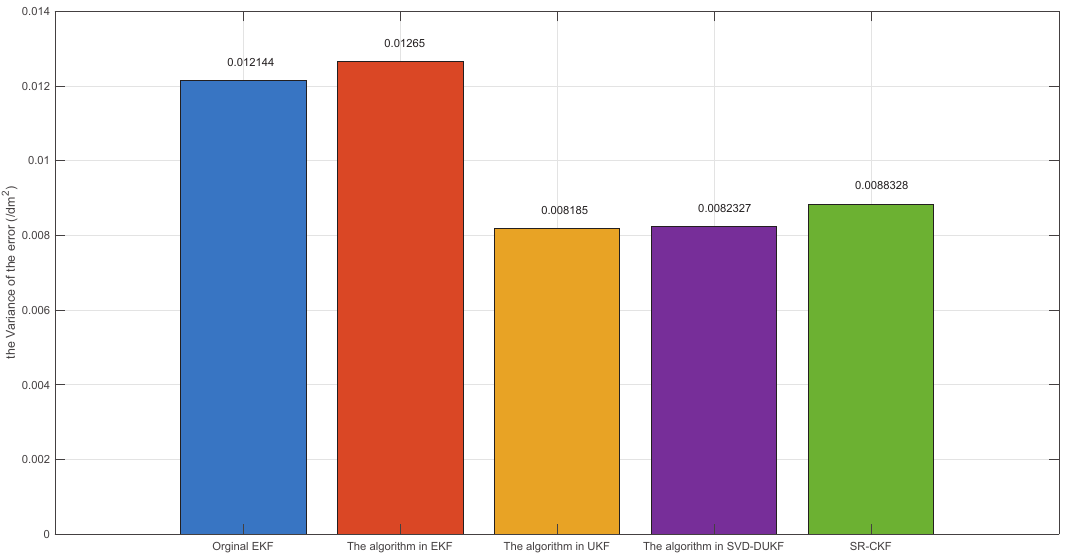
Figure 12. The variance of the localization